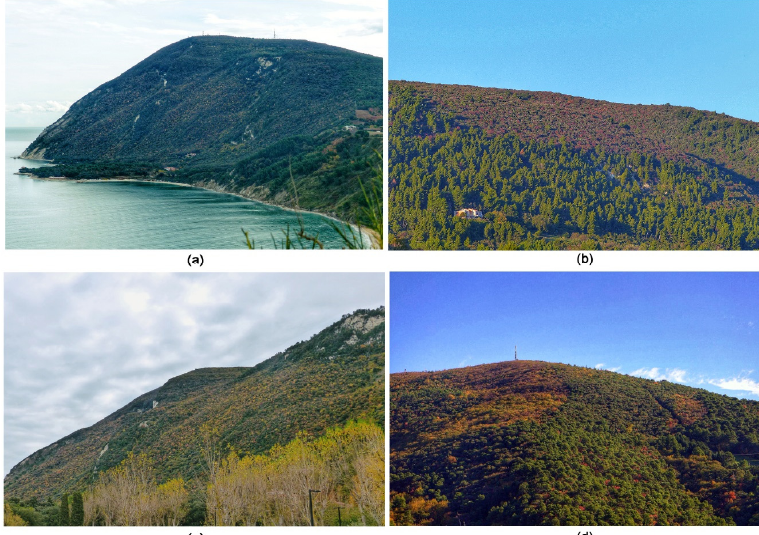
Figure A1. Field phenological forest variation of Mount Conero. a) View of the North-Eastern side of Mount Conero. b) Photo of 14 Nov 2018 on the South side of Mount Conero. The autumn red coloring of Fraxinus ornus allows distinguishing of the forest association Cyclamino hederifolii-Quercetum ilicis (dominated by Quercus ilex) from neighboring Pinus halepensis and P. pinea plantation. c) Photo of 26 Nov 2018 on the eastern side of Mount Conero shows the association Cephalanthero longifoliae-Quercetum ilicis. In brown-yellow colors are the deciduous species (e.g., Acer obtusatum, Ostrya carpinifolia). In green the dominant species Quercus ilex. d) Photo of 19 Nov 2017 on the western side of Mount Conero. The association Asparago acutifolii–Ostryetum carpinifoliae (in brown-yellow color) can be distinguished from the evergreen neighboring Pinus halepensis and P. pinea plantation. Remote Sens. 2019, 11, x FOR PEER REVIEW